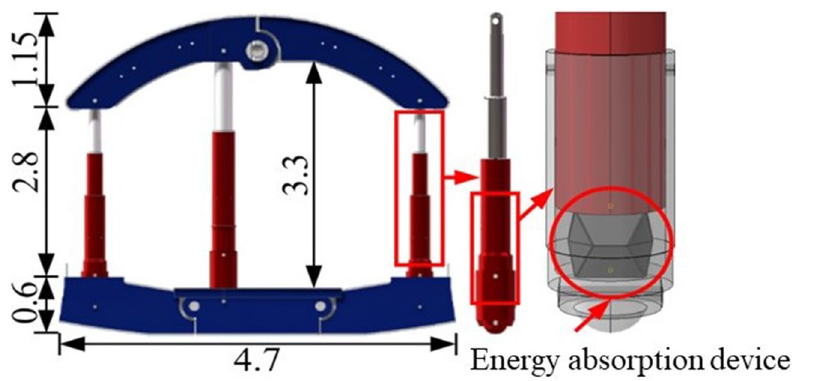
Figure 2. Energy-absorbing yielding anti-impact supporting